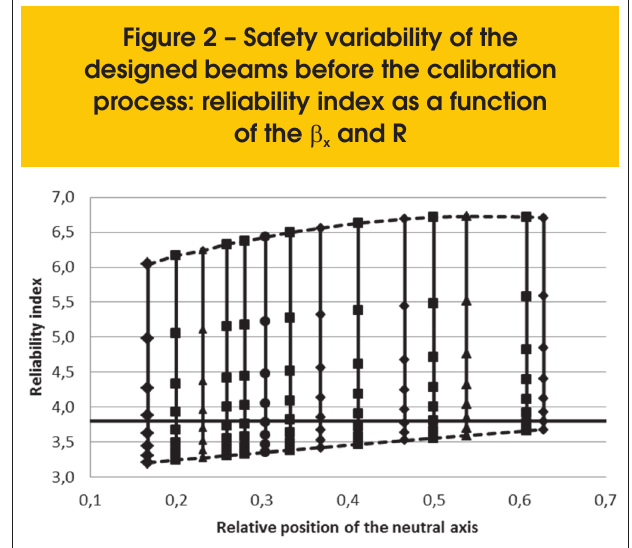
Figure 2 – Safety variability of the designed beams before the calibration process: reliability index as a function of the b and R